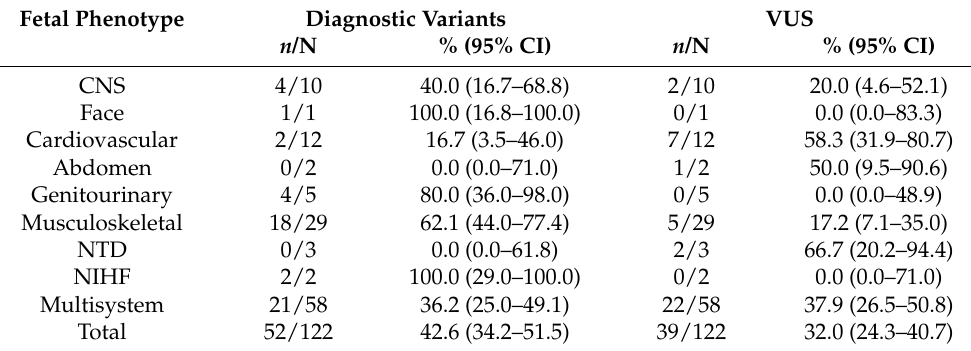
Table 1. Diagnostic variants and variants of unknown significance detected by exome sequencing in different phenotypic groups of